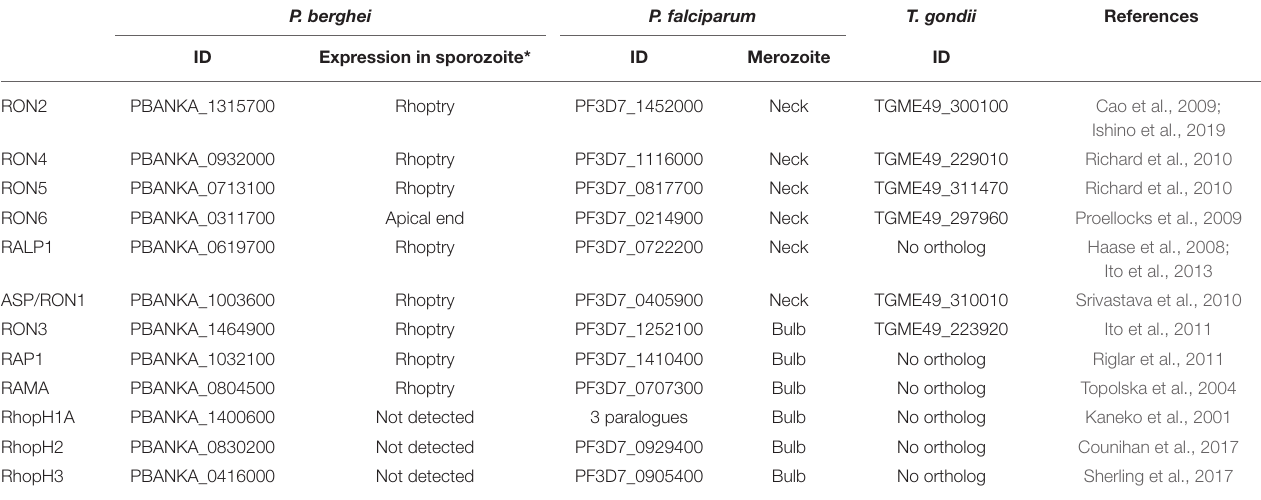
TABLE 1 | The list of rhoptry proteins examined in this